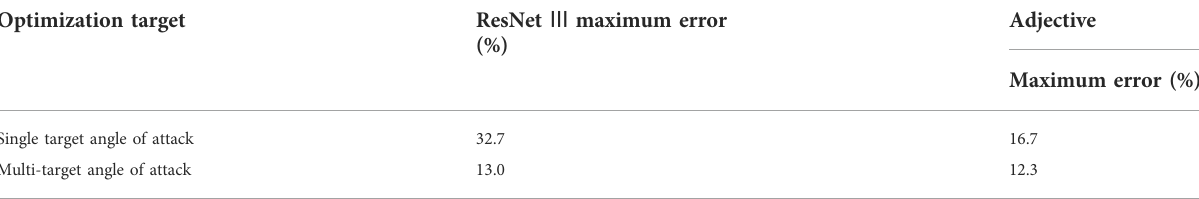
TABLE3Theoptimizationresultsofmulti-networkcoordinationatmultipleanglesofattackandsingleangleofattack,comparedwiththebestairfoil in the data